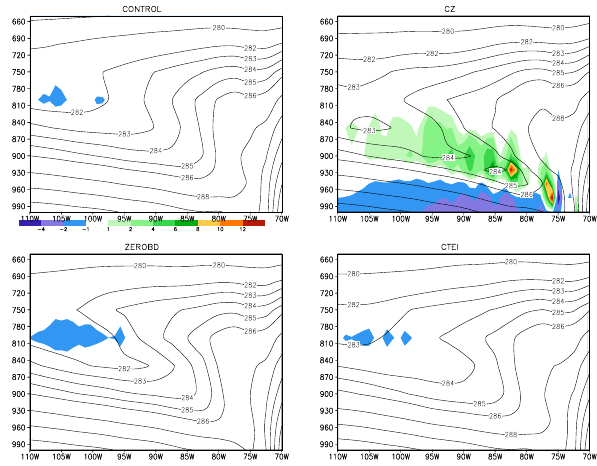
Fig. 11. As in Fig. 10 except for moistening rates (g/kg/day) (shade) due to vertical turbulent diffusion.